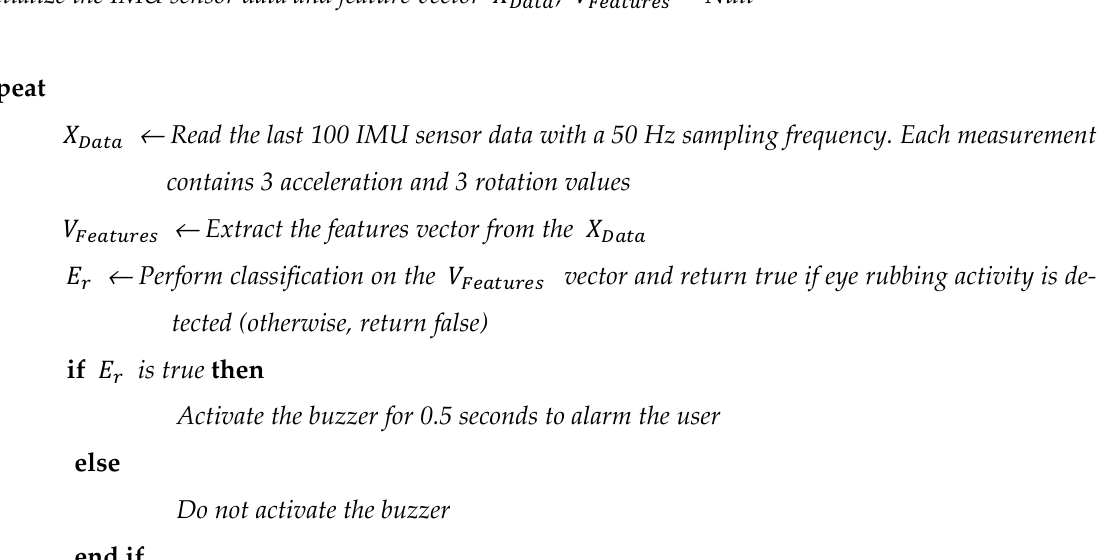
Figure 2. The algorithm outline for eye rubbing detection .